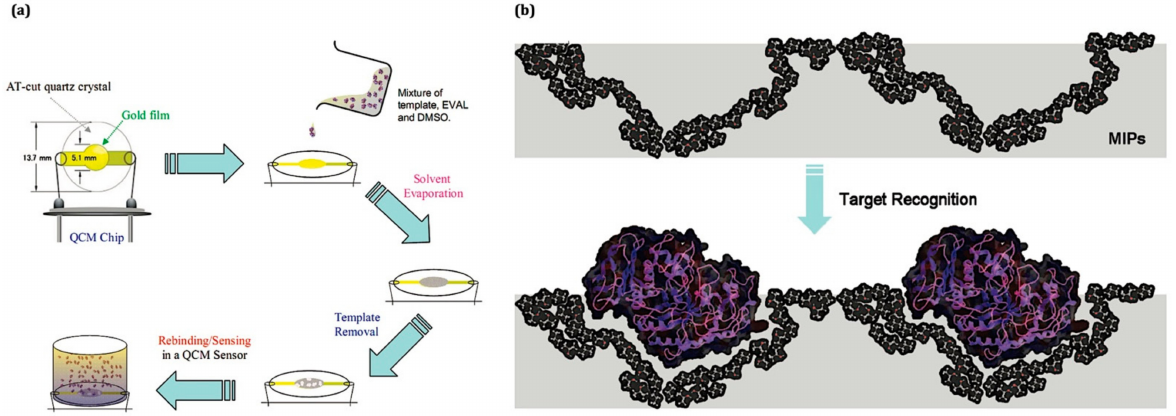
Figure 5. ( a ) QCM biosensor design; ( b ) schematic diagram of non-covalent recognition mechanism for amylase. Reprinted with permission from ref. [152]. Copyright 2011 ACS